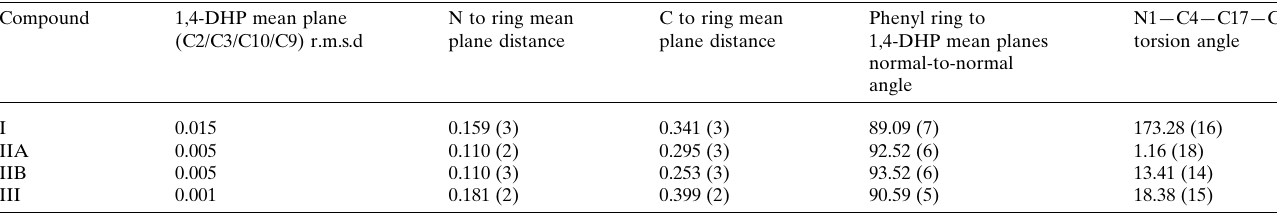
Table 1 Calculated parameters (A˚ , (cid:2) ) related to the 1,4-DHP ring. Compound